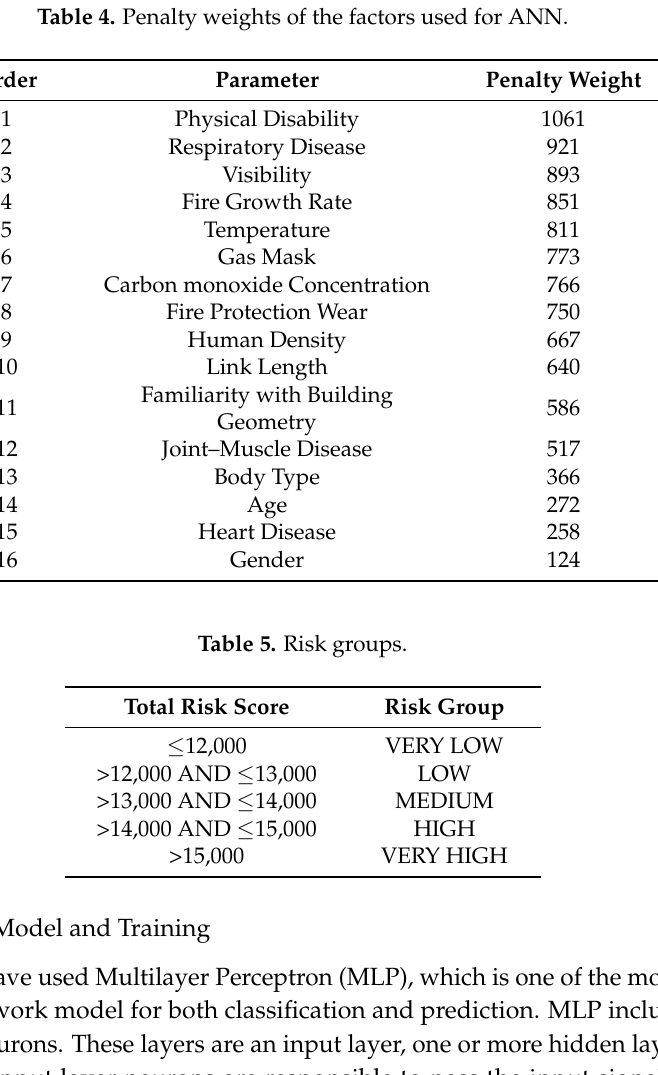
Table 4. Penalty weights of the factors used for ANN.